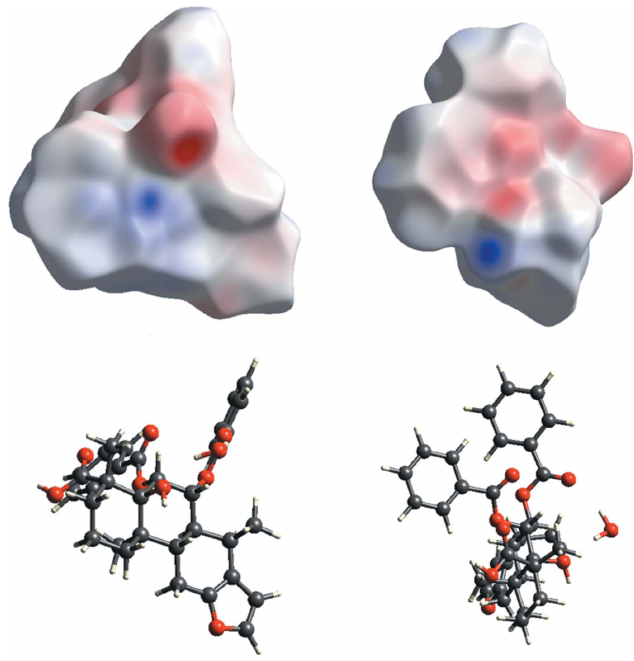
Figure 7 Electrostatic potential surface generated incorporated with the Hirshfeld surface for the title